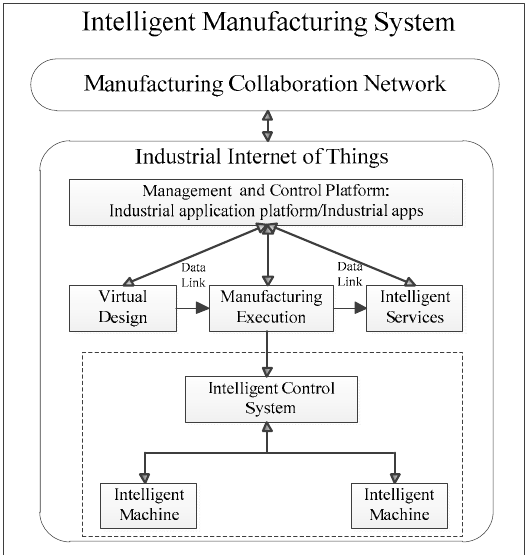
Figure 1. Architecture of intelligent manufacturing system.